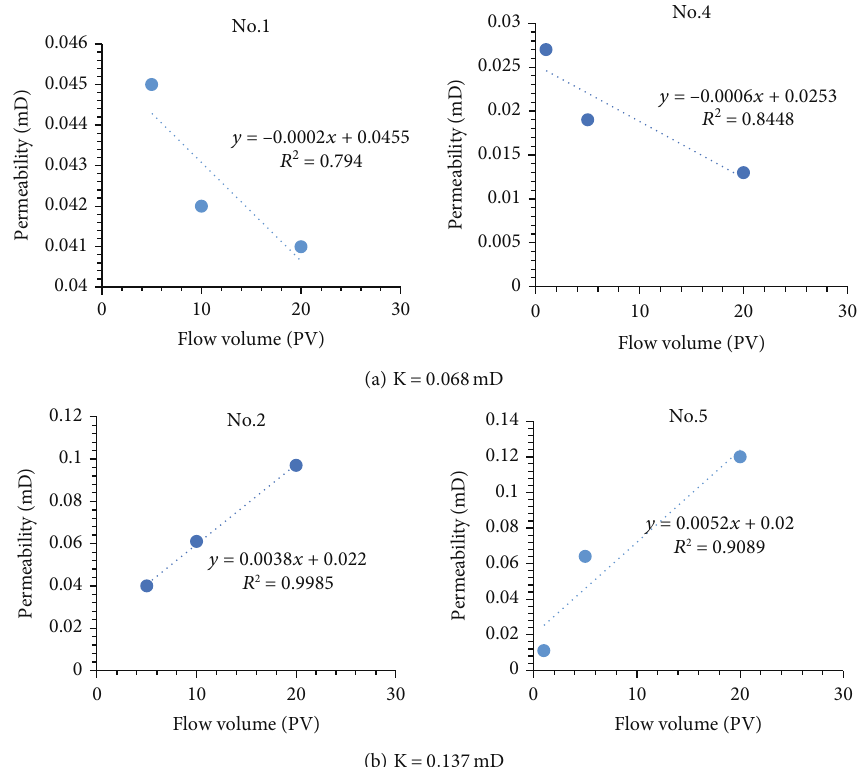
Figure 4: Correlation between DFV and permeability of rock